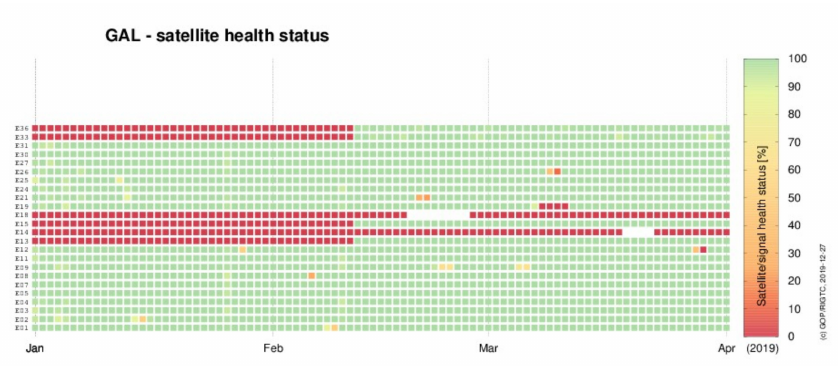
Figure 1. Change of the Galileo constellation: Colors indicates the percentage of navigation records in a day providing a healthy Signal-In-Space status, i.e., all healthy = 100% and all unhealthy =